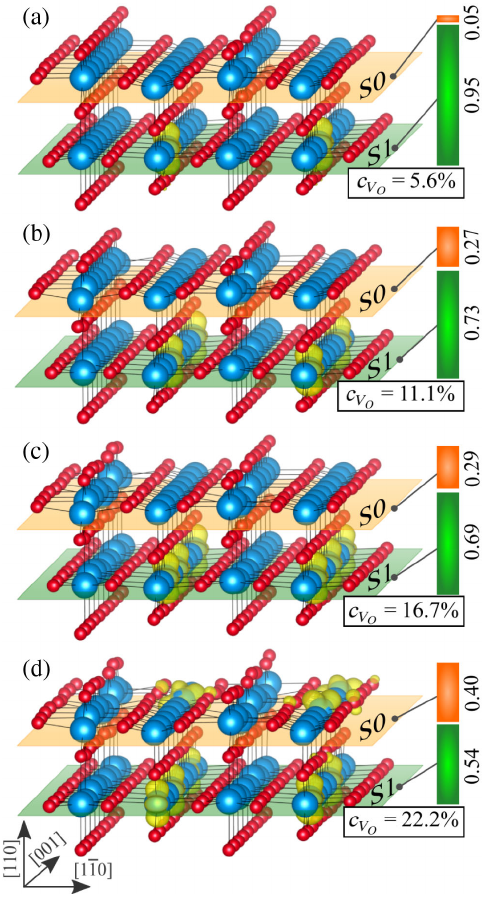
FIG. 2. Polaron distribution in TiO 2 ð 110 Þ . (a) – (d), Most stable polaron configurations obtained by FPMD and subsequent relaxations at the various V concentrations specified in each O panel. The histograms illustrate how often the polarons are found in S 0 (orange) and S 1 (green) Ti sites during the FPMD